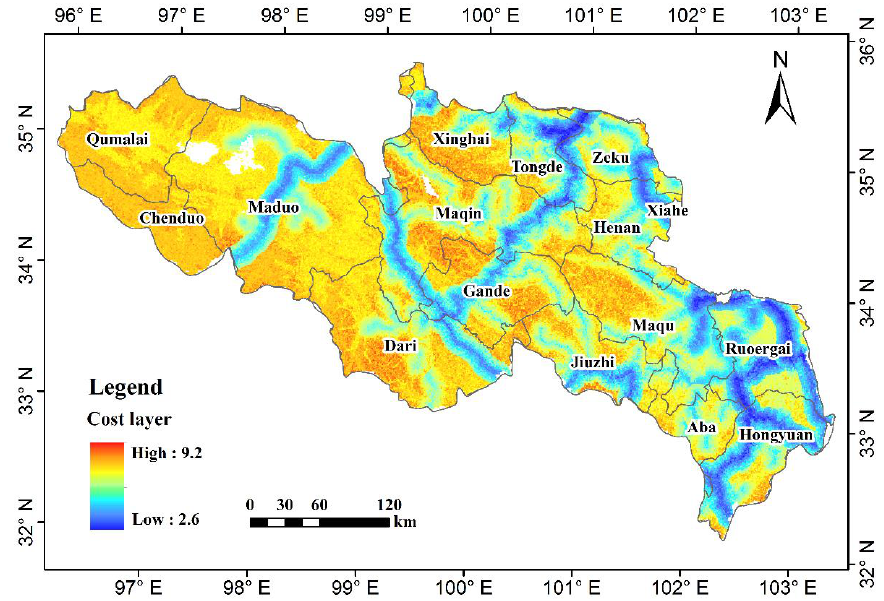
Figure A1. Cost layer obtained with cLHS.